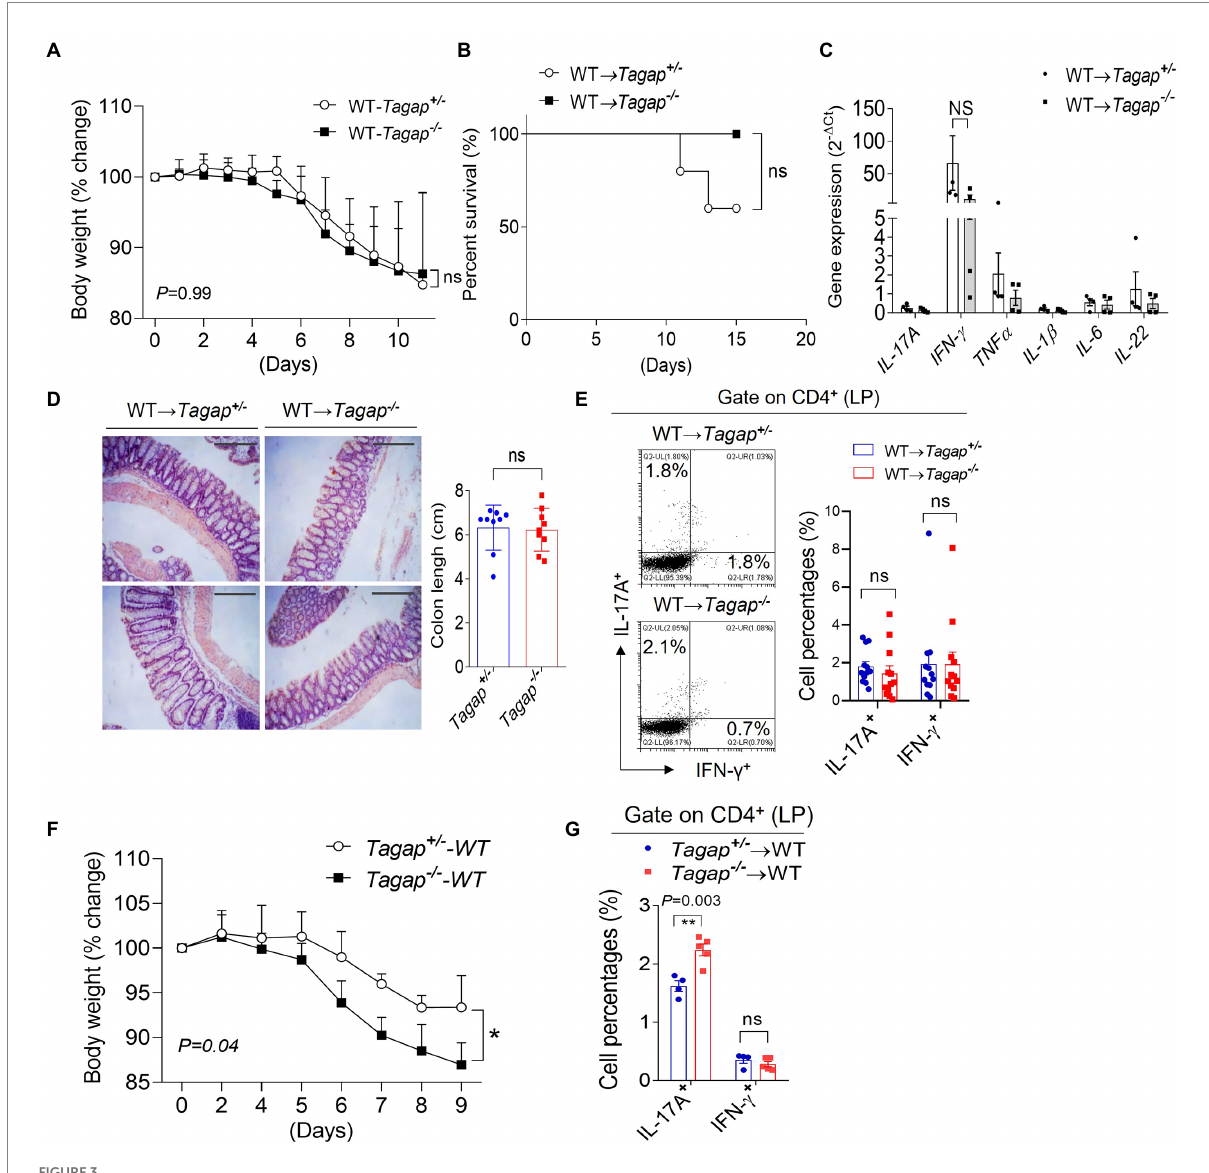
FIGURE 3 FMT rescue the severe phenotype of TAGAP-deficient mice in colitis. (A,B) Littermate control mice or TAGAP-deficient mice were transplanted feces from wild-type mice as described in the Method, followed by 3% of DSS treatment for 5 days, and then changed to normal water. Mice weight curve was shown in panel (A) , n = 9; mice survival curve was shown in panel (B) , n = 5. Mice weight curve (A) and survival curve (B) were done in separate experiments. (C) Mice were treated as in A, and colonic samples were isolated from littermate control mice or TAGAP-deficient mice after DSS treatment for 7 days, followed by real-time PCR analysis for the indicated genes. (D) Mice were treated as in A, and hematoxylin staining of transversal sections of colon sample after DSS treatment for 10 days was shown (left panel), Scale bar: 150 μ m. Colon length was shown (right panel), n = 9. (E) Mice were treated as in A, and cells were isolated from lamina propria of control mice or TAGAP-deficient mice after DSS treatment for 5 days, followed by flow cytometry analysis of CD4 + IL-17A + and CD4 + IFN- γ + cells, n = 12. (F) Wild-type mice were transplanted feces from littermate control mice or TAGAP-deficient mice as described in the Method, followed by 3% of DSS treatment for 5 days, and mice weight change was shown, n = 4. (G) Mice were treated as in F, and cells were isolated from lamina propria of wild-type recipient mice after DSS treatment for 5 days, followed by flow cytometry analysis of CD4 + IL-17A + and CD4 + IFN- γ + cells, n = 5. * p < 0.05, ** p < 0.01, *** p < 0.001, **** p < 0.0001 based on 2-way ANOVA (A,F) , Log-rank (Mantel-Cox) Test for (B) and unpaired T test (C–E,G) . All error bars represent SEM of technical replicates. Data are representative of three independent